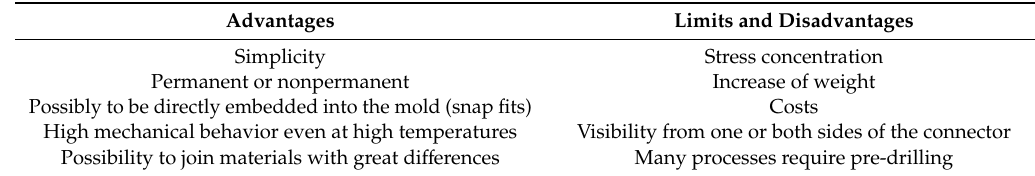
Table 2. Pro and cons of mechanical